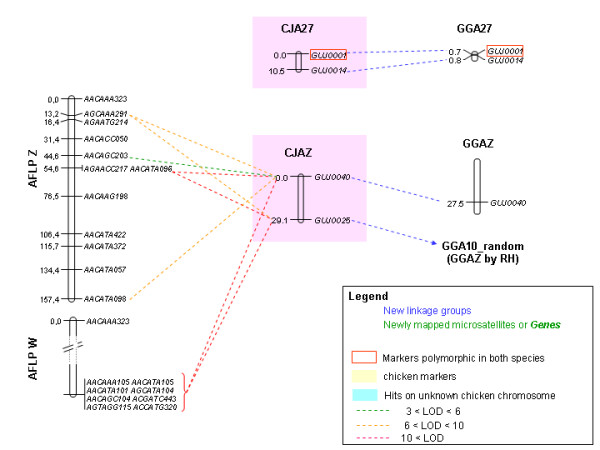
Alignments of Japanese quail microsatellite and AFLP maps and links to the assembled chicken sequence. Left: AFLP linkage groups from [14]; center: integrated microsatellite and gene map (this study); right: chicken February 2004 sequence assembly [22]. AFLP and microsatellite genetic maps are in cM and the sequence assembly is in Mb. New quail linkage groups have blue titles and new microsatellite and gene markers are in green. Genes are in boldface italic. Microsatellite markers informative in both species are in red boxes. Chicken markers have a yellow background. Quail microsatellites or genes with similarity to chicken sequence of unknown location (chrun) have a blue background. Dotted lines linking the microsatellite and the AFLP maps indicate positive results of two-point linkage between the markers, with supporting LOD scores of 3 to 6 (green), 6 to 10 (orange) or more than 10 (red).